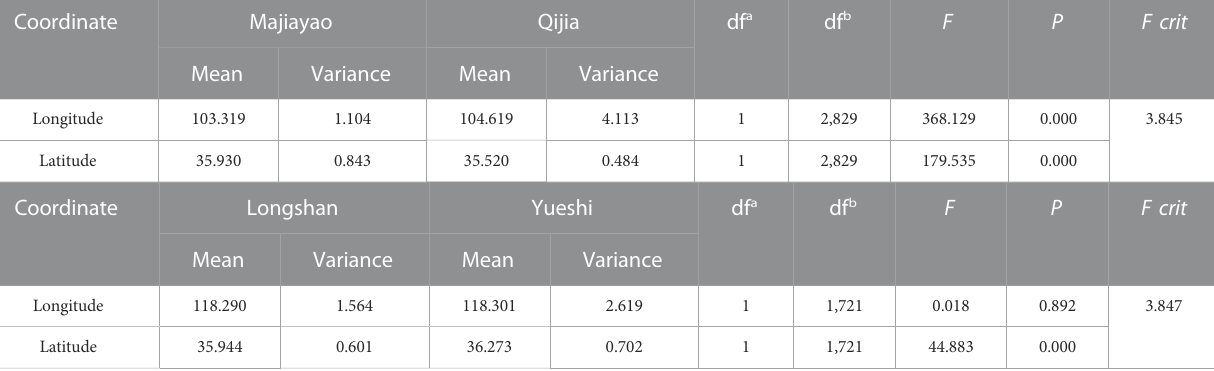
TABLE 2 One-way ANOVA of the coordinates of archaeological sites between different cultures. Panel (A): the Majiayao culture vs. the Qijia culture. Panel (B): the Longshan culture vs. the Yueshi culture.